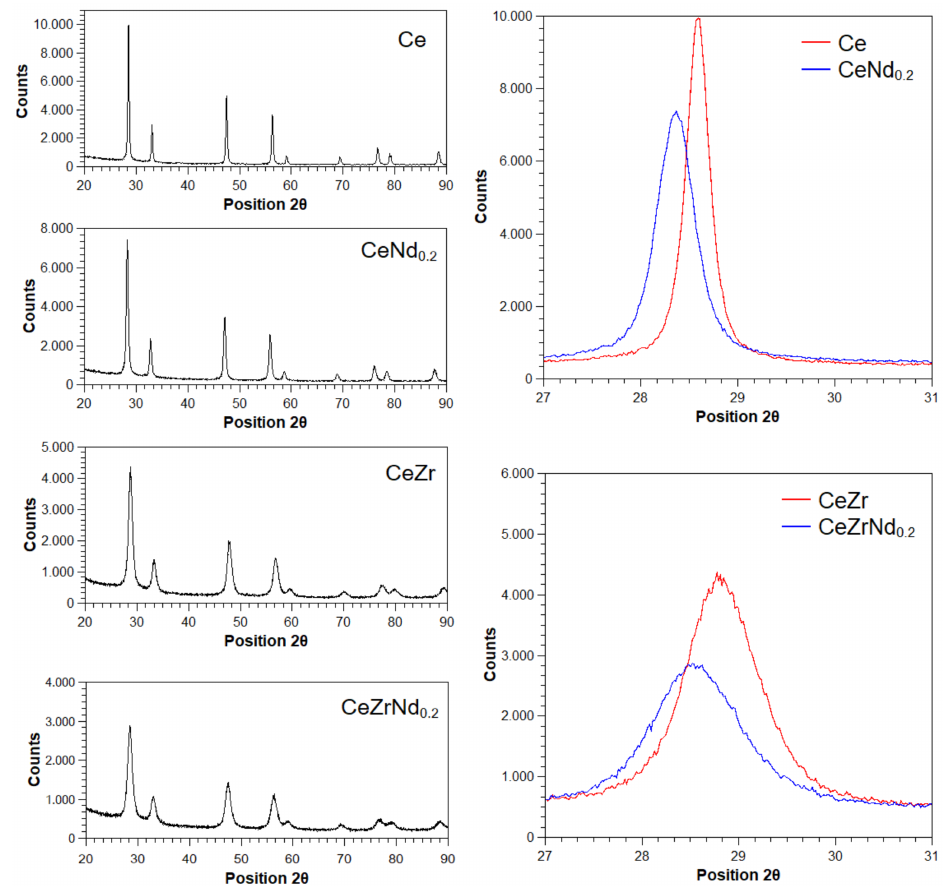
Figure 5. Comparison of XRD profiles of Ce with CeNd and CeZr with CeZrNd. On the right, details of comparison in the 2 θ range between 24 and 32 degrees, showing the shift of the main peak as a result of the insertion of Nd into the fluorite structure. The lattice parameters of the identified phases are reported in Table S1 (in Supplementary Materials).